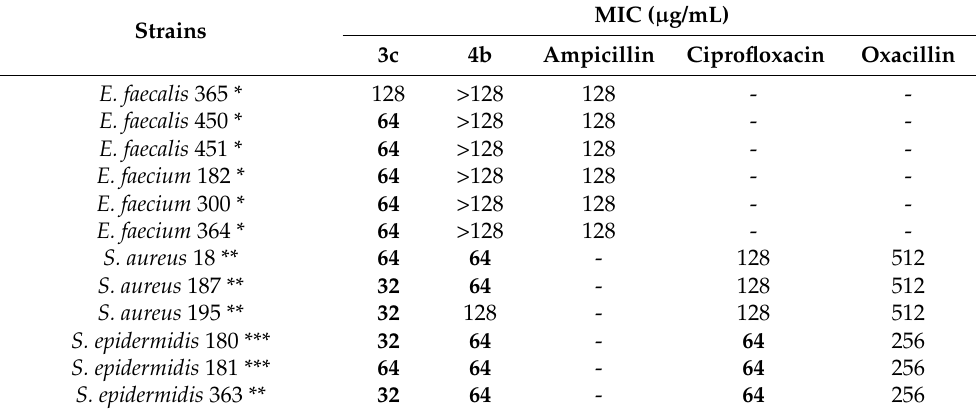
Table 2. MICs of compounds 3c and 4b against the most clinically relevant bacteria of Gram-positive species, obtained from experiments carried out at least in triplicate, and those of the reference antibiotics, expressed as µ